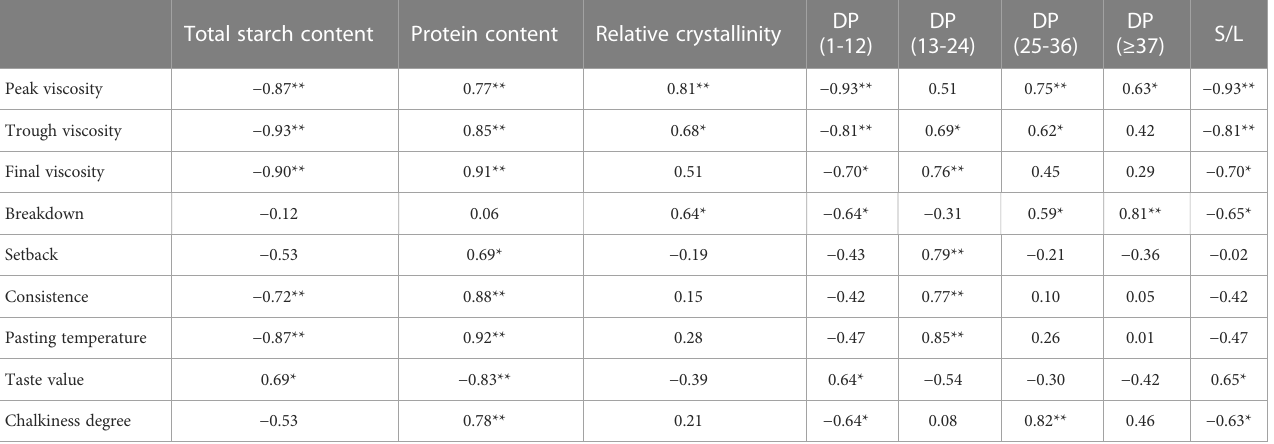
TABLE 4 Correlations of the RVA pro fi le and taste value with chemical composition and starch